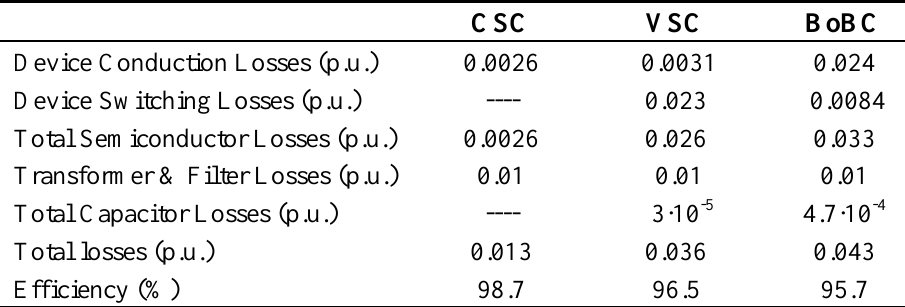
Table 7. 50 MW Benchmark application loss